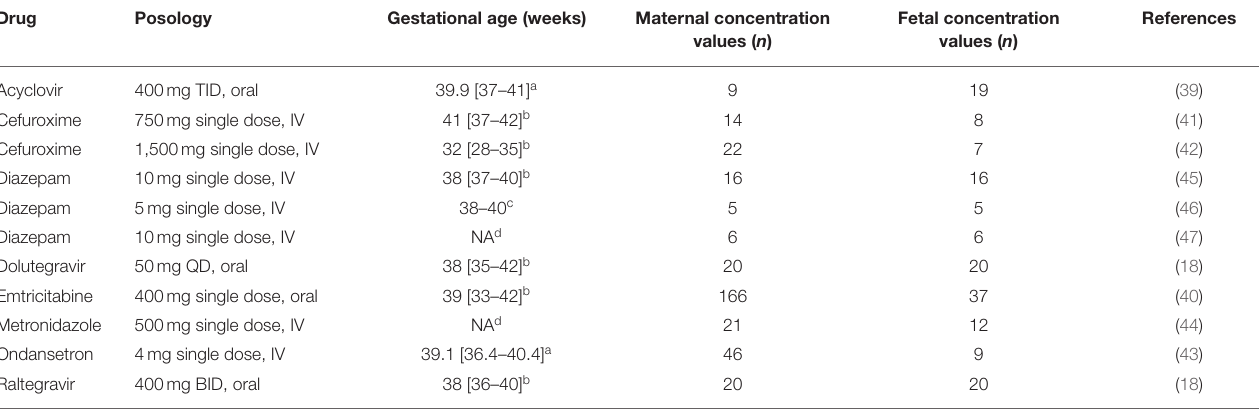
TABLE 3 | Characteristics of the clinical studies used for model evaluation. Drug Posology Gestational age